Question: Write a single sentence explaining what this figure depicts.
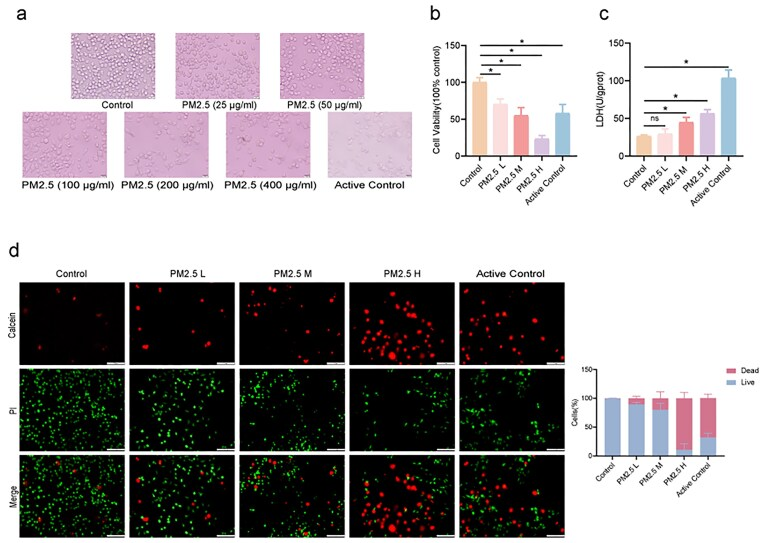
Answer: PM 2.5 exposure causes damage to J774A.1 cells. J774A.1 cells were treated with different dose concentrations of PM 2.5 and positive control (LPS + ATP) for 24 h. (a) Changes in cell morphology were observed in PM 2.5 and positive control. Scale bar: 20 μm (white, lower right). (b) The cell viability changes were detected by MTT assay. (c) The LHD kit was used to detect LDH exposure in the supernatant of treated J774A.1 cells to assess cell viability in each group. (d) Calcein/PI staining assay was performed to detect the cell membrane integrity and metabolic activity of the cells to accurately assess the effect of PM 2.5 and positive control treatments on J774A.1 cell viability. Scale bar: 100 μm (white, lower right). The data shown as mean ± SD ( n = 3). ns, P ≥ .05; * P < .05.